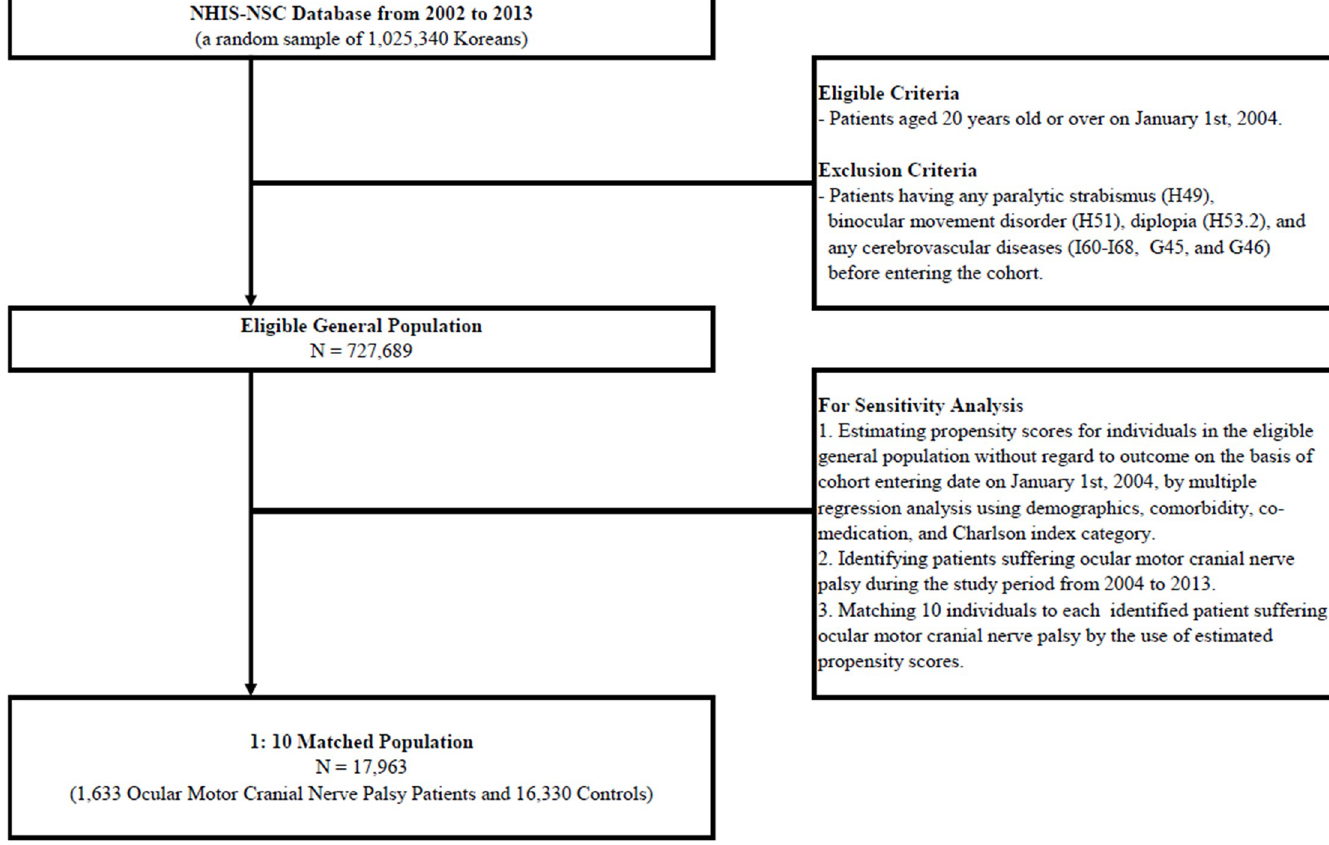
Fig 1. Flow chart according to eligible criteria of main analyses and sensitivity